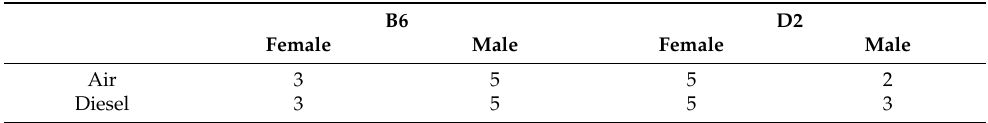
Table 4. Numbers of mice by strain, sex, and treatment for the proinflammatory cytokine gene expression